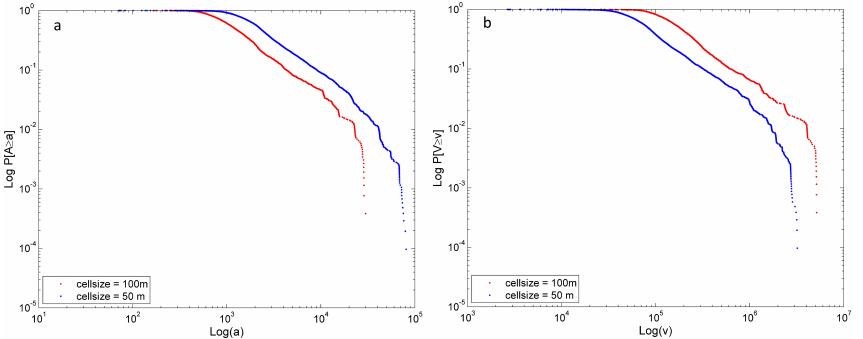
Fig. 2. The prob ability of drainage area and volume, computed for TR = 1m and D 50 = 480µm during ebbing phase (a) drainage area, (b) drainage volume. Table 1. Average value of the exponent (considering all tidal ranges and grain sizes), standard deviation obtained and correlation coefficient for the drainage area and drainage volume power laws computed with a grid size of